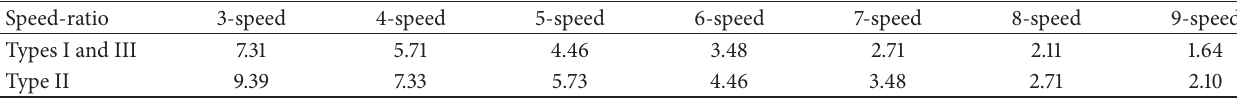
Table 2: The speed-ratio of the three